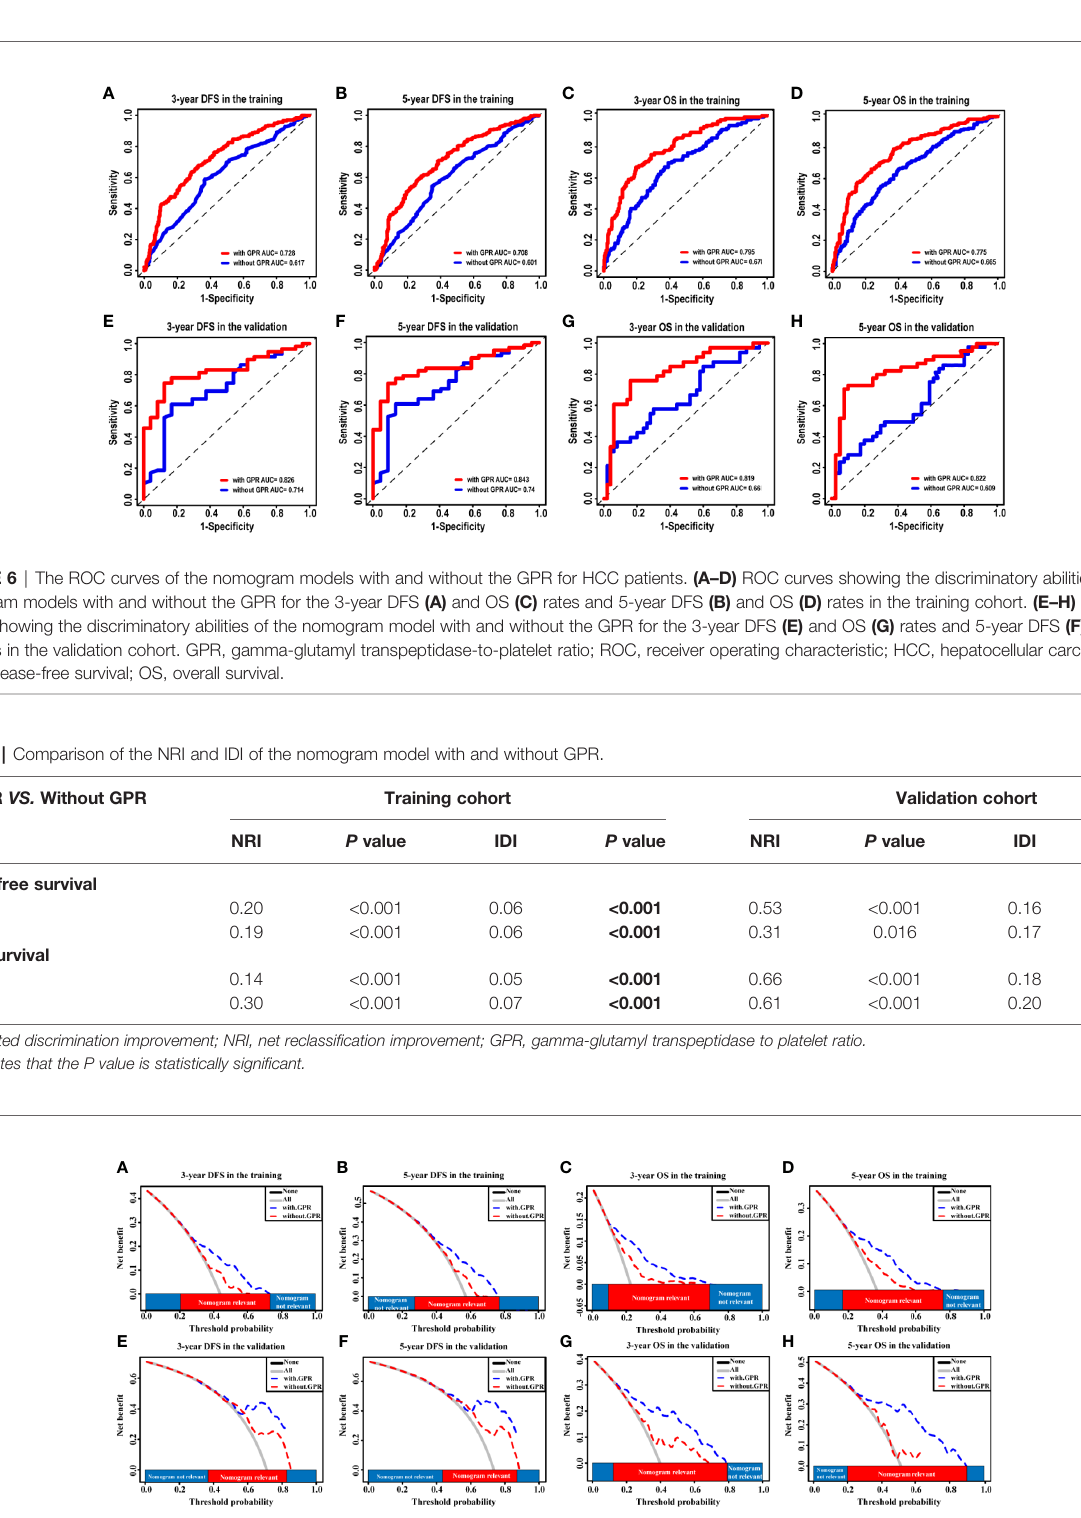
FIGURE 7 | The DCA curves of the nomogram models with and without the GPR for HCC patients. (A – D) DCA curves showing the clinical utility of the nomogram models with and without the GPR for the 3-year DFS (A) and OS (C) rates and 5-year DFS (B) and OS (D) rates in the training cohort. (E – H) DCA curves showing the clinical utility of the nomogram models with and without the GPR for the 3-year DFS (E) and OS (G) rates and 5-year DFS (F) and OS (H) rates in the validation cohort. GPR, gamma ‐ glutamyl transpeptidase ‐ to ‐ platelet ratio; ALB, albumin; DCA, decision curves analysis; HCC, hepatocellular carcinoma; DFS, disease-free survival; OS, overall